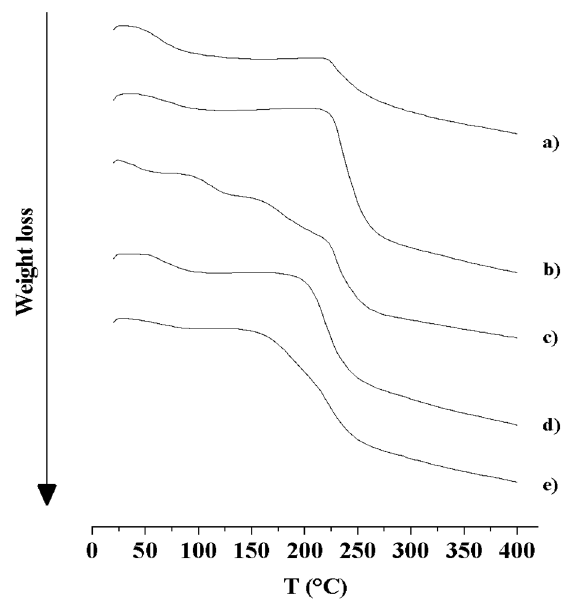
Figure 6. TGA thermograms of: SAP (a), HA MS (b), HA-CL MS (c), HA–SAP MS (d), HA-CL–SAP MS (e).